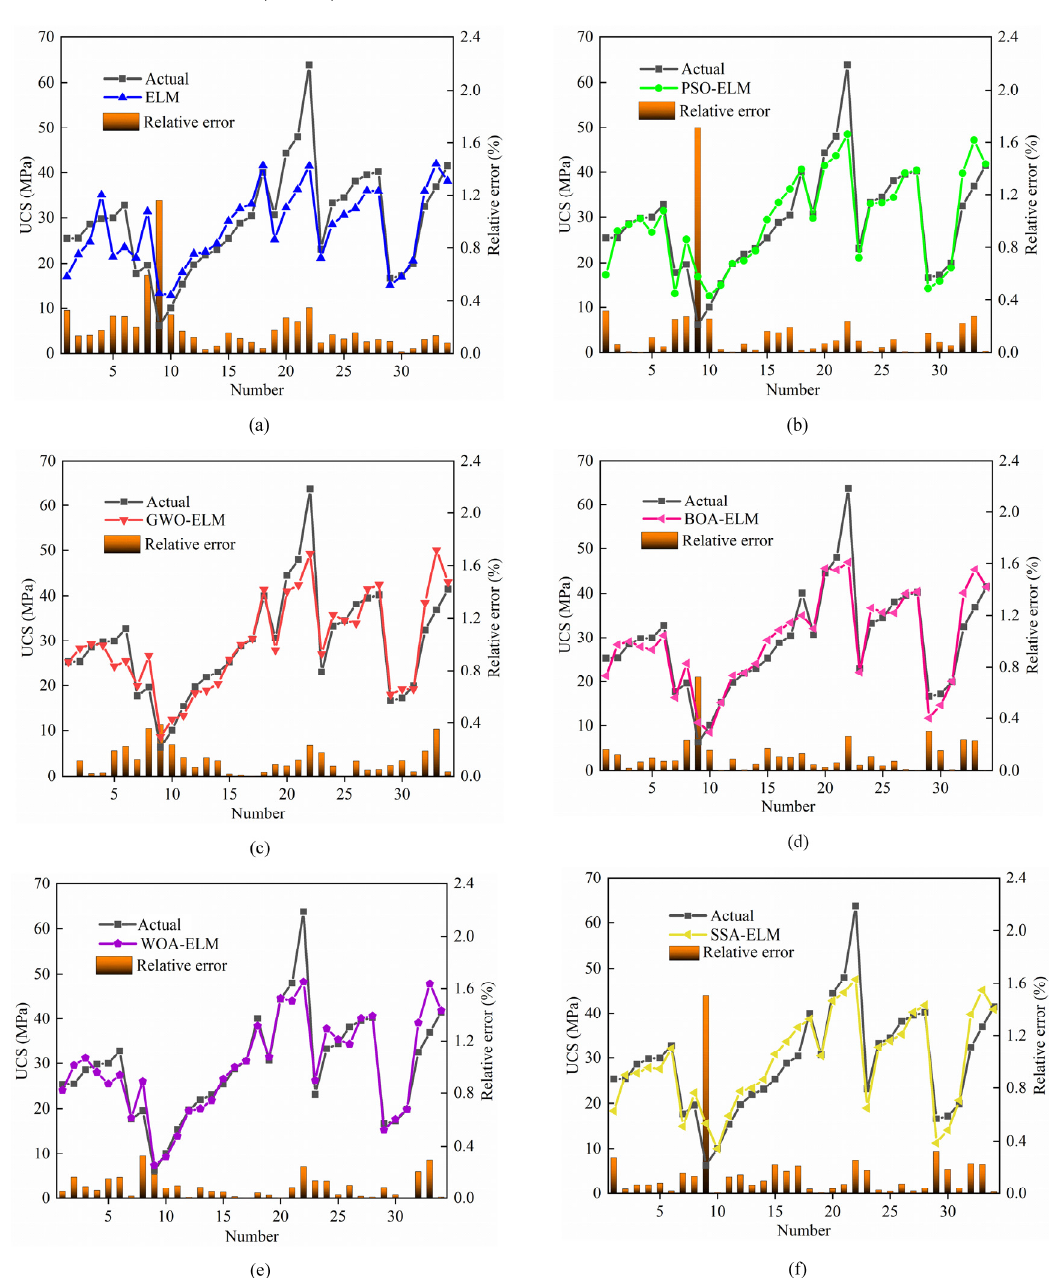
Figure 6. Performance of single ELM models and hybrid ELM models optimized by PSO, GWO, WOA, BOA, and SSA. ( a ) predicted results and relative errors of ELM model; ( b ) predicted results and relative errors of PSO-ELM model; ( c ) predicted results and relative errors of GWO-ELM model; ( d ) predicted results and relative errors of BOA-ELM model; ( e ) predicted results and relative errors of WOA-ELM model; ( f ) predicted results and relative errors of SSA-ELM model.